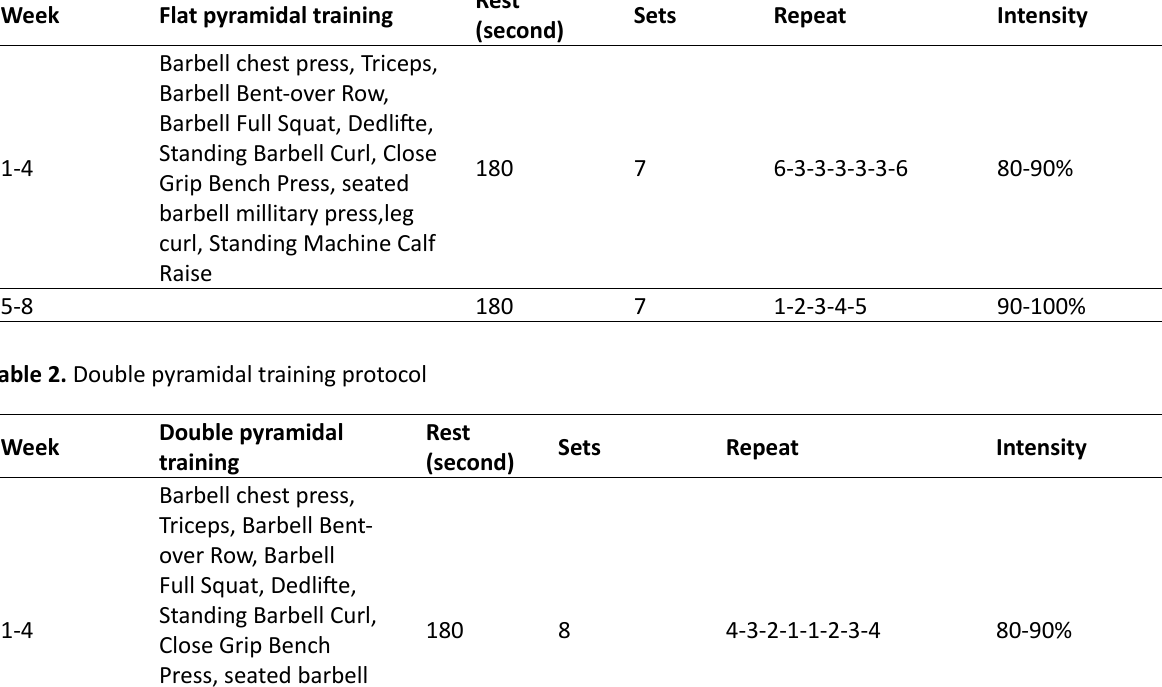
Table 1. Flat pyramidal training protocol